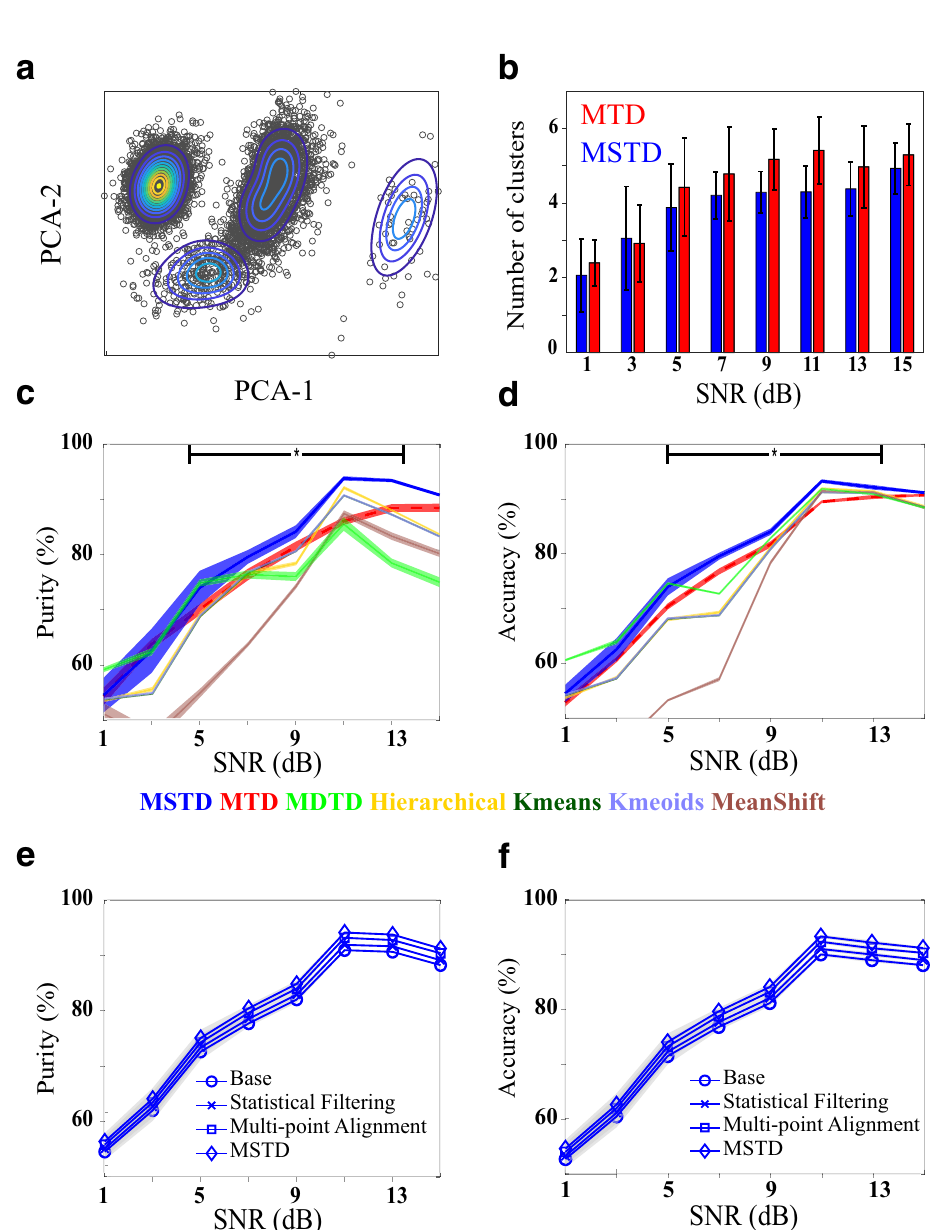
Figure 5. Evaluating clustering phase of the MSTD algorithm using simulated dataset 35,36 in the clustering phase. ( a ) An example of MSTD fitted on a simulated session. ( b ) The average number of clusters determined by each method for different SNRs. The standard deviation is shown as error bars. ( c , d ) The accuracy and purity of clustering outcomes for MSTD compared to six other methods. The shaded area is the standard error. The horizontal line with star shows where the values between MSTD and MTD differ significantly. ( e , f ) Investigating the contribution of the proposed multi-point alignment and statistical filtering on clustering performance in terms of purity and accuracy. Results show the higher impact of multi-point alignment than statistical